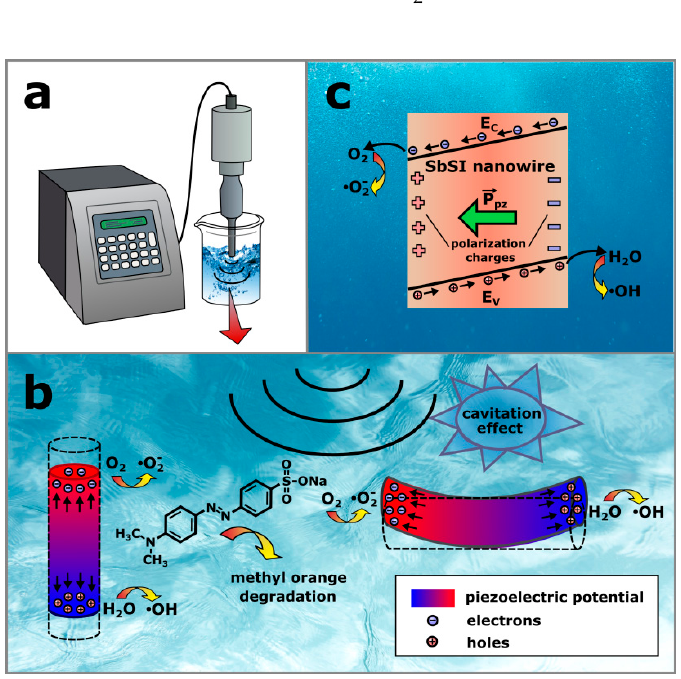
Figure 8. Schematic illustrations of ( a ) an experimental setup, ( b ) piezocatalytic degradation of methyl orange using SbSI nanowires, and ( c ) energy band diagram of SbSI under a piezoelectric potential. Detailed description in the text.